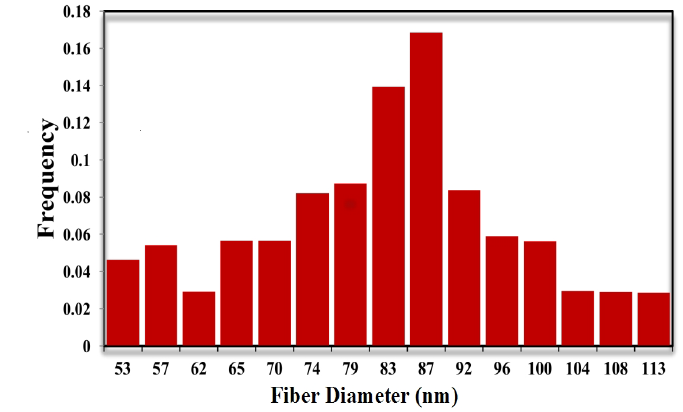
Fig. 3. Distribution curves of the diameters of electrospun CS/PEO nanofibers (samples containing tetracycline